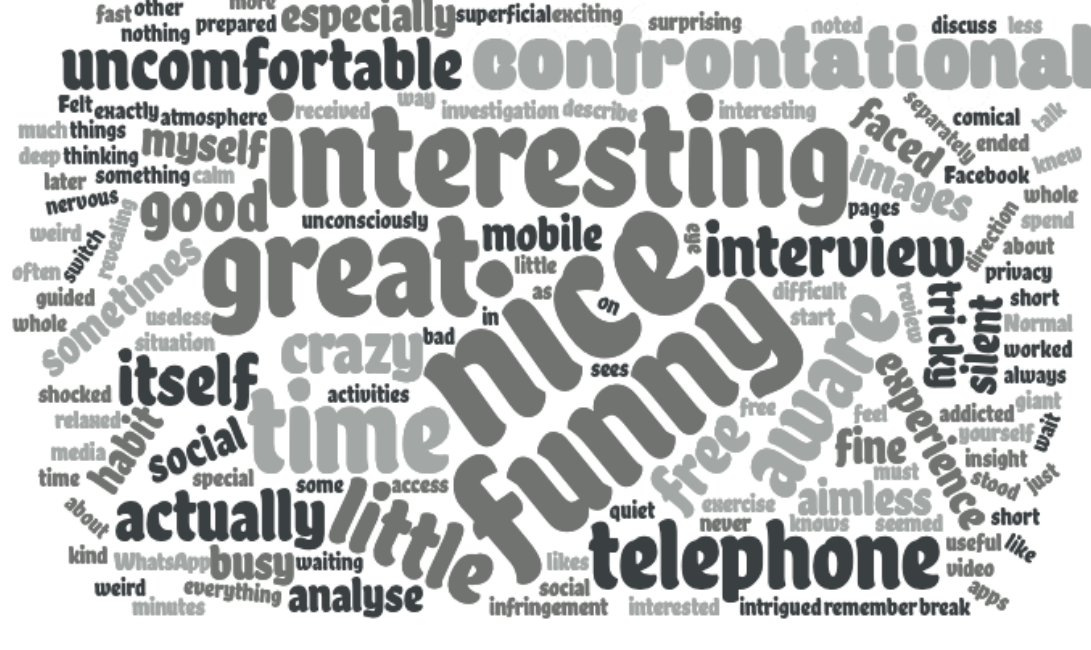
Figure 6. Word cloud depicting words used by participants (n=53) in response to the statement “Please describe how you experienced the stimulated recall interview.” Larger words represent more frequently used words. Font darkness is for decorative purposes only and does not represent other aspects of these